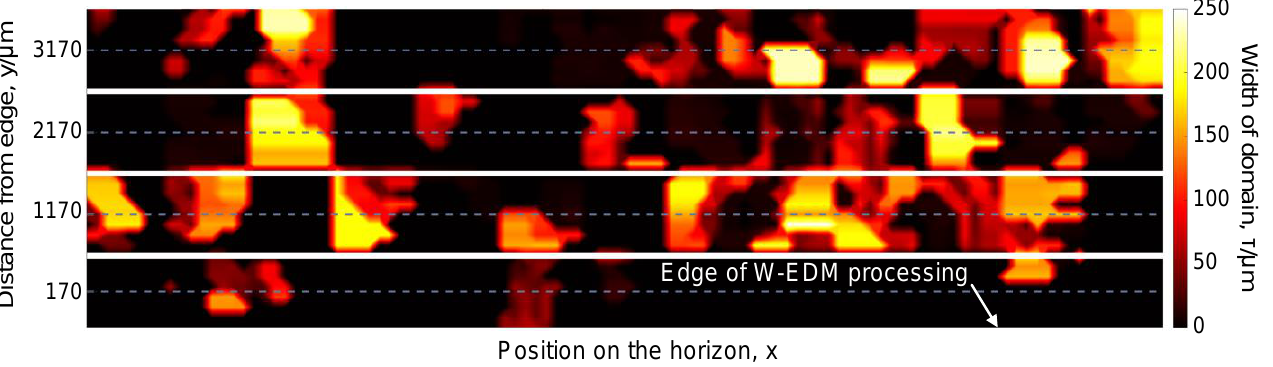
Figure 10. Distribution of different width magnetic domains after W-EDM